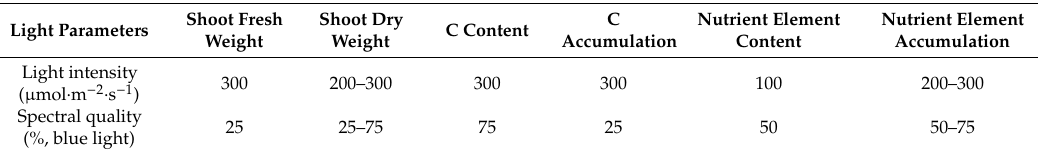
Table 3. Optimal intensity and quality of CL for maximal shoot fresh and dry weight, C and nutrient element content and accumulation of hydroponic